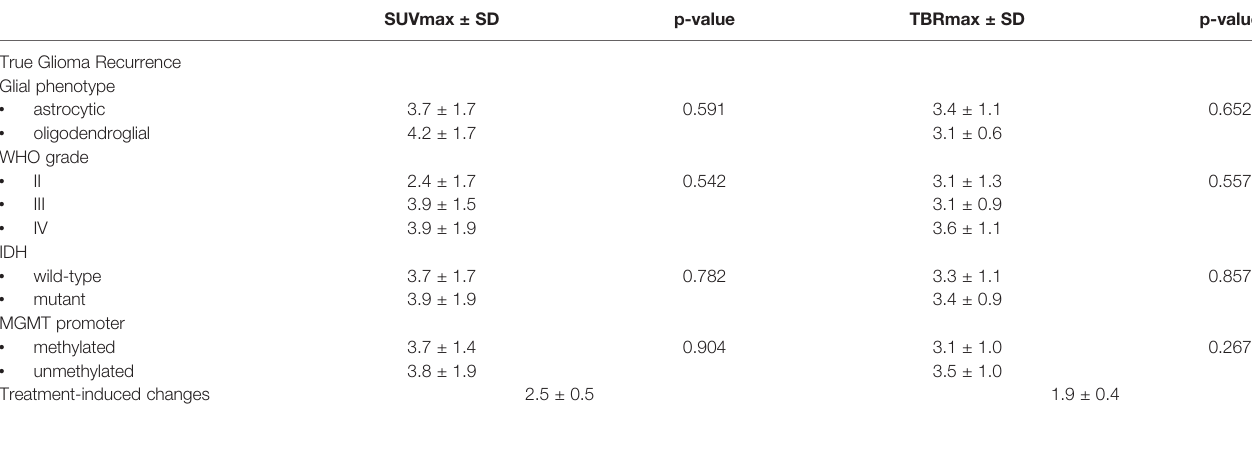
TABLE 2 | Static semiquantitative 18 F-FET PET parameters.